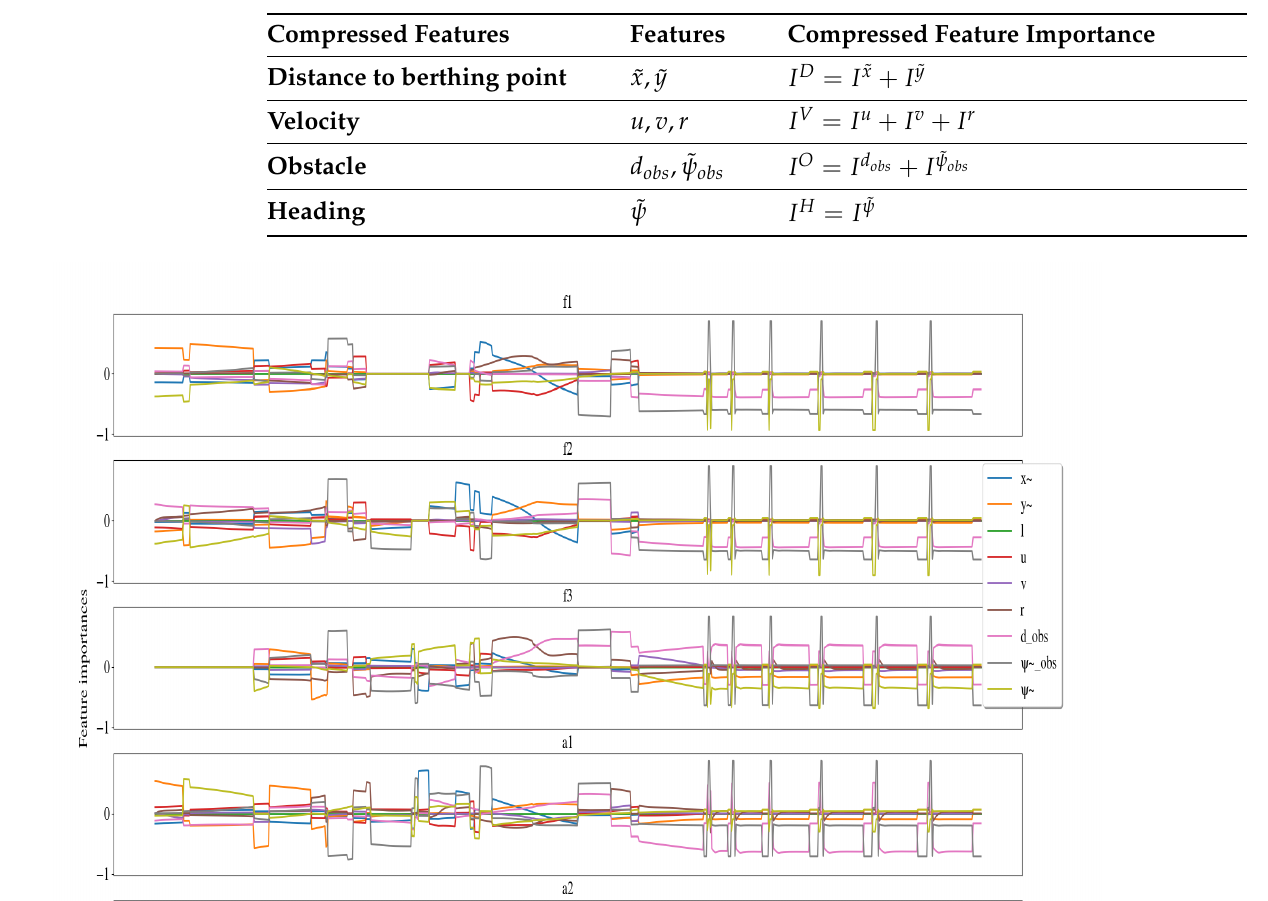
Table 4. Overview of mapping from features as the agent and explainer receives them to the compressed feature representation used for the visualizations for the operator/seafarer.